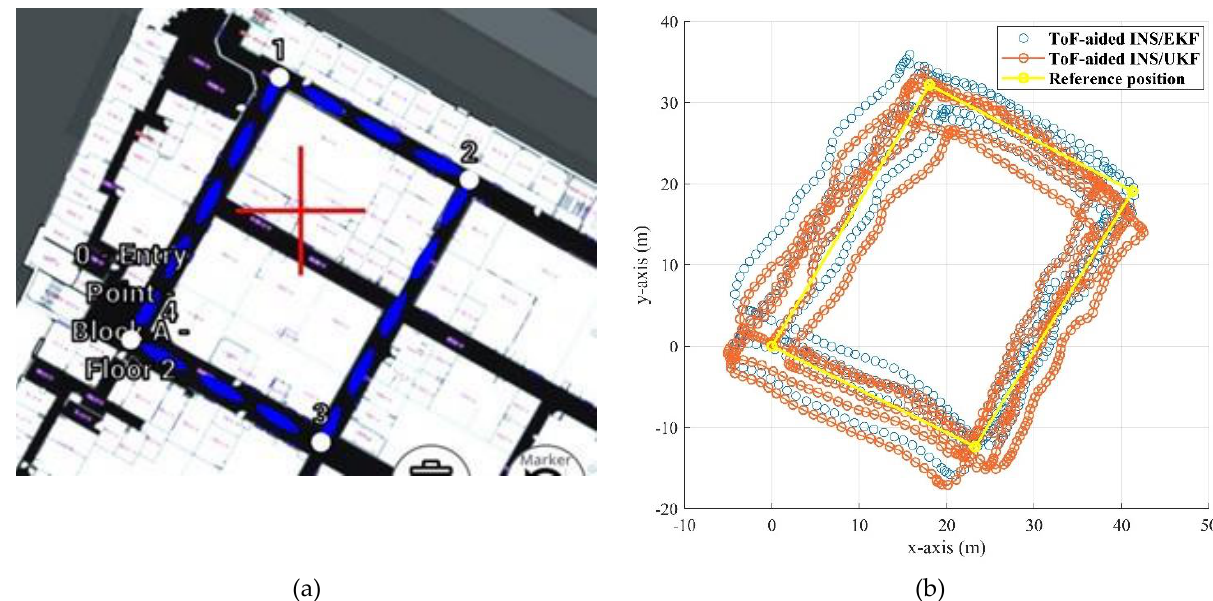
Figure 16. The estimated heading for the second scenario.